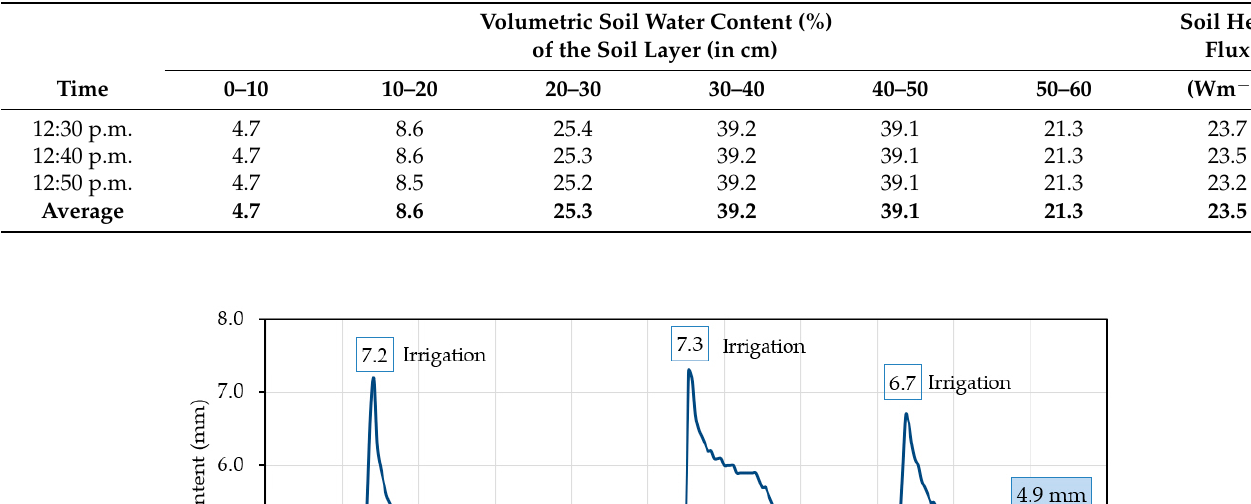
Table 2. Soil water moisture (vol%) for the depth of 60 cm of the soil profile in the potato field.